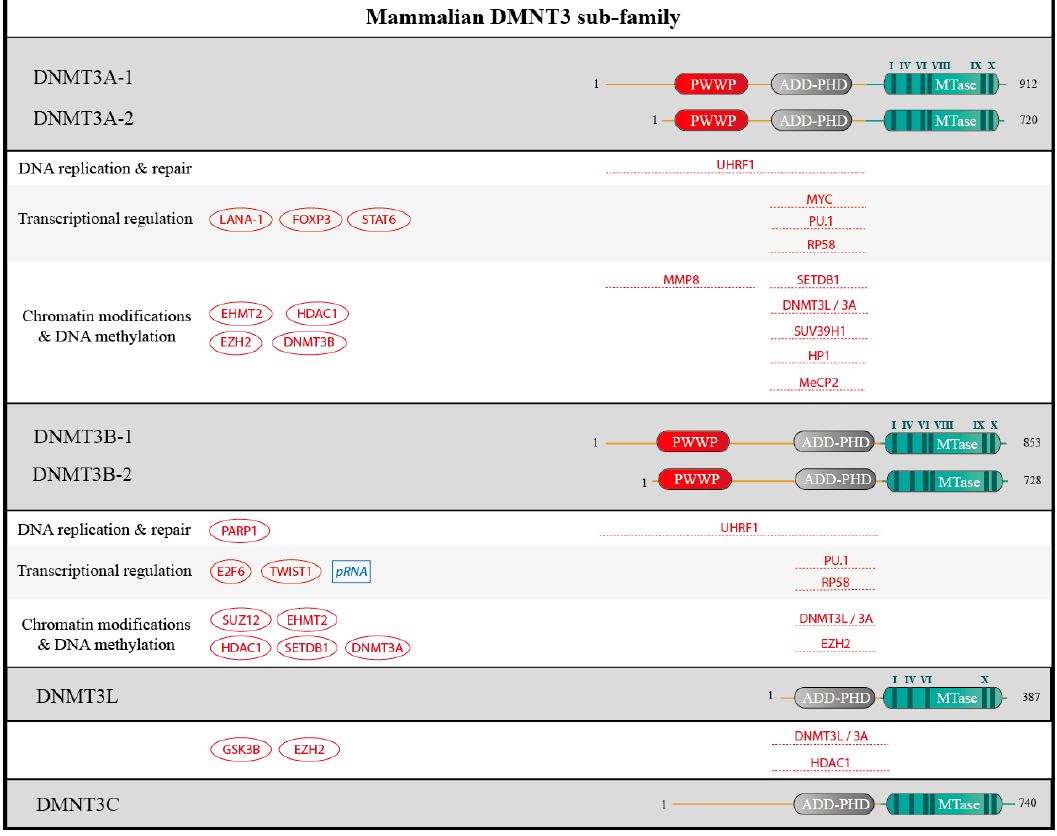
Figure 5. Schematic structure of DNMT3 sub-family and partners. Human DNMT3A, DNMT3B, DNMT3L and the rodent DNMT3C contain 912, 953, 387 and 740 amino acids residues, respectively and for the longest isoforms. For DNMT3A and DNMT3B, transcriptional isoforms due to alternative